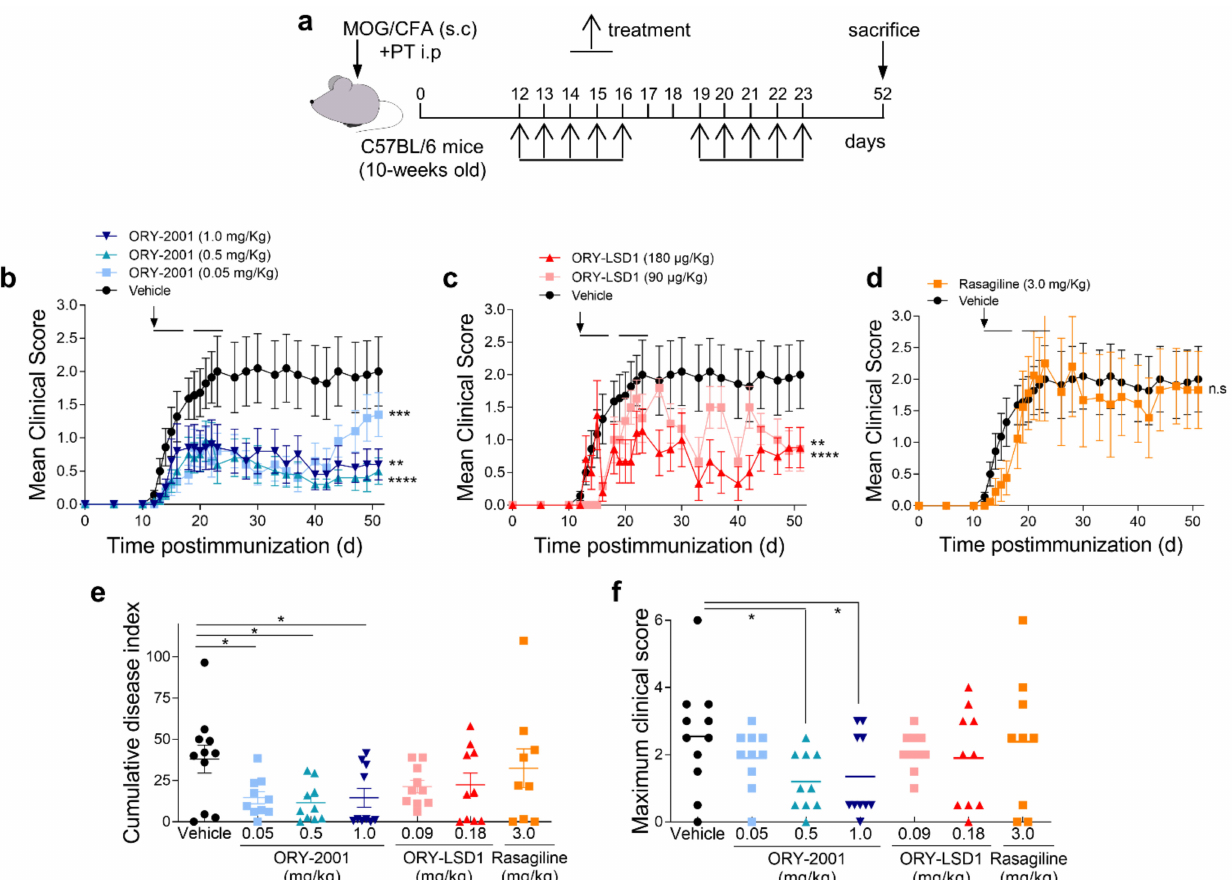
Figure 1. Treatment with ORY-2001 reduces clinical symptoms and EAE severity. ( a ) Chronic progressive EAE was induced in C57BL/6 mice by immunization with MOG 35–55 . Immunized animals were treated orally during two periods of five days (horizontal bars in ( b – d )) with vehicle, with ORY-2001 (( b ), at 1.0, 0.5, or 0.05 mg/kg), with ORY-LSD1 (( c ), at 180 or 90 µ g/kg) or with rasagiline (d, 3.0 mg/kg) starting at the onset on day 12 (pointed by an arrow in ( b – d )) and sacrificed 52 days after immunization; ( b – d ) the data represent the progression of the disease evaluated as the mean clinical score. ** p < 0.01, *** p < 0.0005, **** p < 0.0001 between vehicle and treated mice. n.s: no statistical significance; ( e ) the cumulative disease index (the sum of the clinical scores reached for each animal every day until day 51 post-immunization); ( f ) the maximum clinical score reached by each animal in any day during the entire period investigated are shown in each experimental group (mean and individual scores). N = 11 mice/group for vehicle; N = 10 mice/group for ORY- 2001 treatment; N = 10 mice/group for ORY-LSD1 treatment, and N = 9 mice/group for rasagiline treatment. * p < 0.05 between vehicle and ORY-2001-treated mice. All data represent mean ± SEM. Compounds were administered once daily for five consecutive days in two cycles, from day 12 to 16 and from day 19 to 23 post-immunization. Control mice were treated with vehicle (2% v / v Tween-80 + 98% HP β CD (13% w / v )) following the same administration regime. HP β CD was included to facilitate dissolution. Mice were scored daily for signs of EAE according to the following clinical scoring system: 0, no clinical signs; 0.5, partial loss of tail tonicity; 1, complete loss of tail tonicity; 2, flaccid tail and abnormal gait; 3, complete hind leg paralysis; 4, hind leg paralysis with hind body paresis; 5, hind and foreleg paralysis; and 6, death. Intermediate phenotypes were scored as a half integer. Animals were sacrificed when they kept a score of 5 more than 24 h. Investigators which administered the compounds and scored the animals were blinded to the